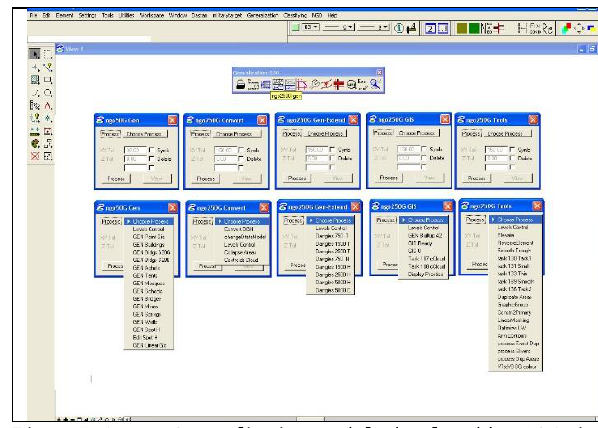
Figure 7. A new Generalization module developed by NGO in Microstation